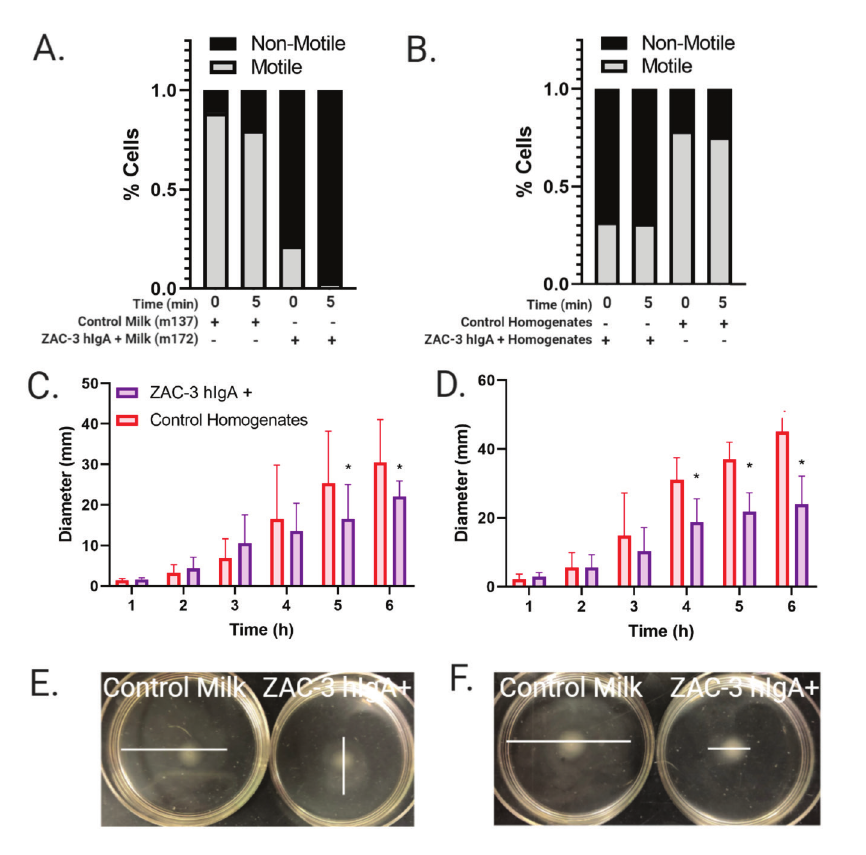
Figure 5. ZAC-3 hIgA in Milk Inhibits Motility of V. cholerae O1. (A) Liquid motility assay, whereby mid-log phase V. cholerae O395 were treated with a 1:100 dilution of control milk, from m137, or ZAC-3 hIgA-containing milk from m172 and imaged for 10 seconds at both 0 and 5 minutes post treatment. Mo- tile bacteria were counted as those that were seen to move between frames. There is a significant decrease ( P < 0.005) in motility in V. cholerae treated with ZAC-3 hIgA-positive milk in comparison to control milk at both 0- and 5-minutes post treatment. Data comprised 3 technical replicates. (B) Liquid motility assay was performed as described, with V. cholerae O395 expressing mCherry treated with either a 1:100